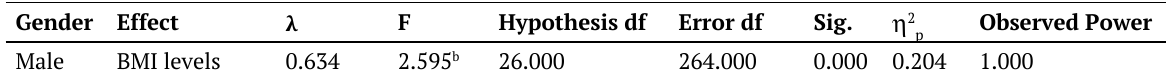
Table 2. The results of the Multivariate Tests (MANOVA a )